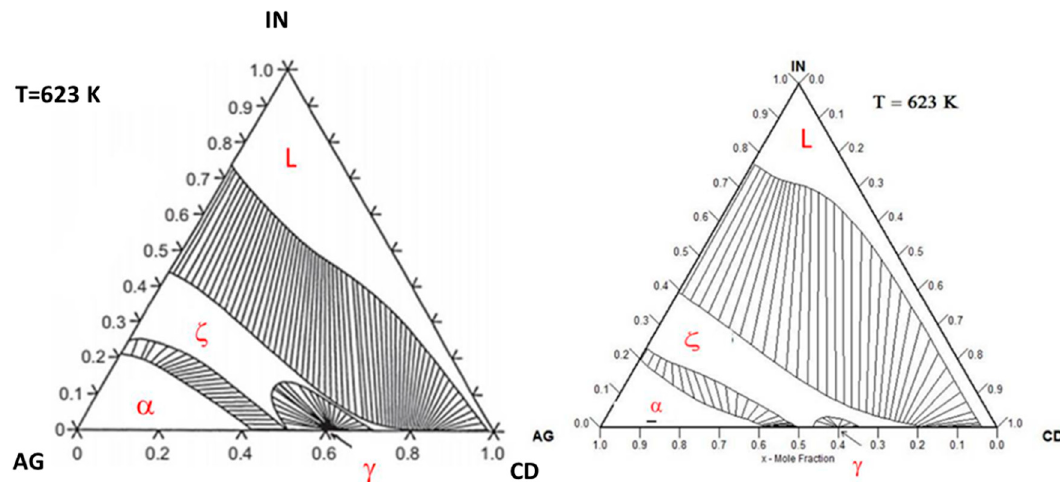
Figure 3. Comparison between the isothermal sections (350 °C) calculated previously by Desgranges [49] (left figure) and recently by Fischer et al. [45] (right figure).